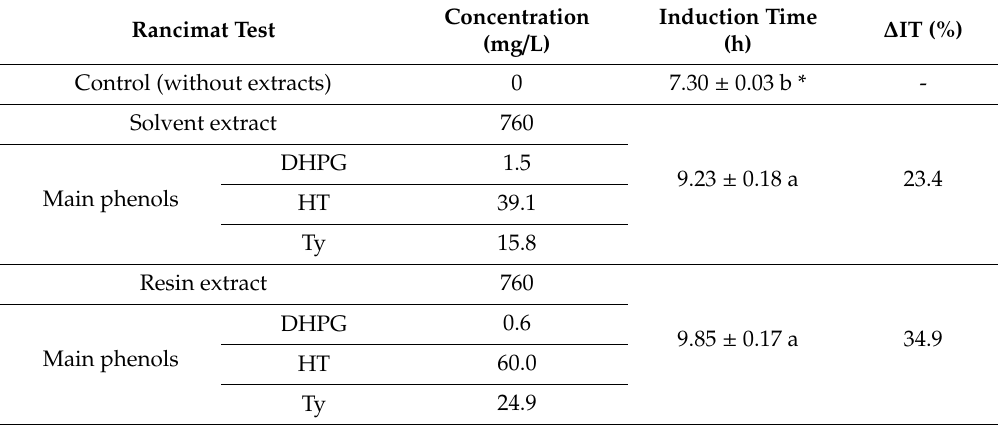
Table 4. Activity determined by Rancimat method of each phenolic extract obtained by solvent or resin from the mixture of the three samples. The induction time of each extract was statistically